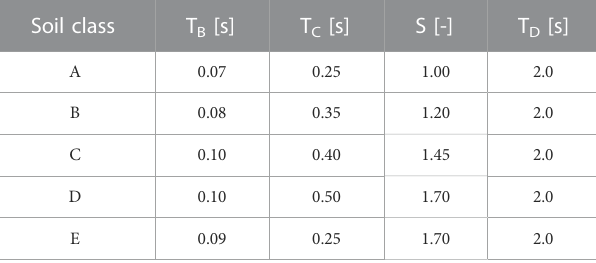
TABLE 2 Parameters de fi ning the response spectrum for the different soil classes SIA 261 (2020). Soil class